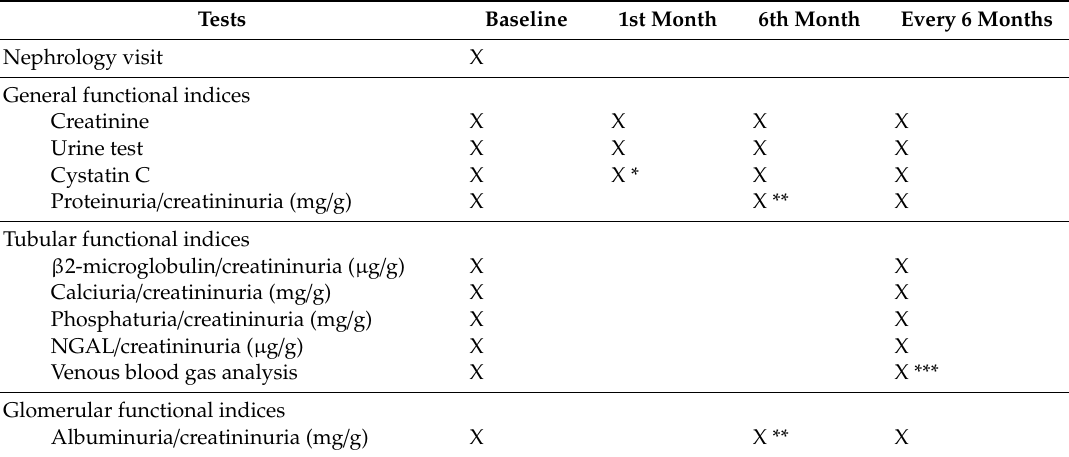
Table 4. Scheme of nephrology monitoring